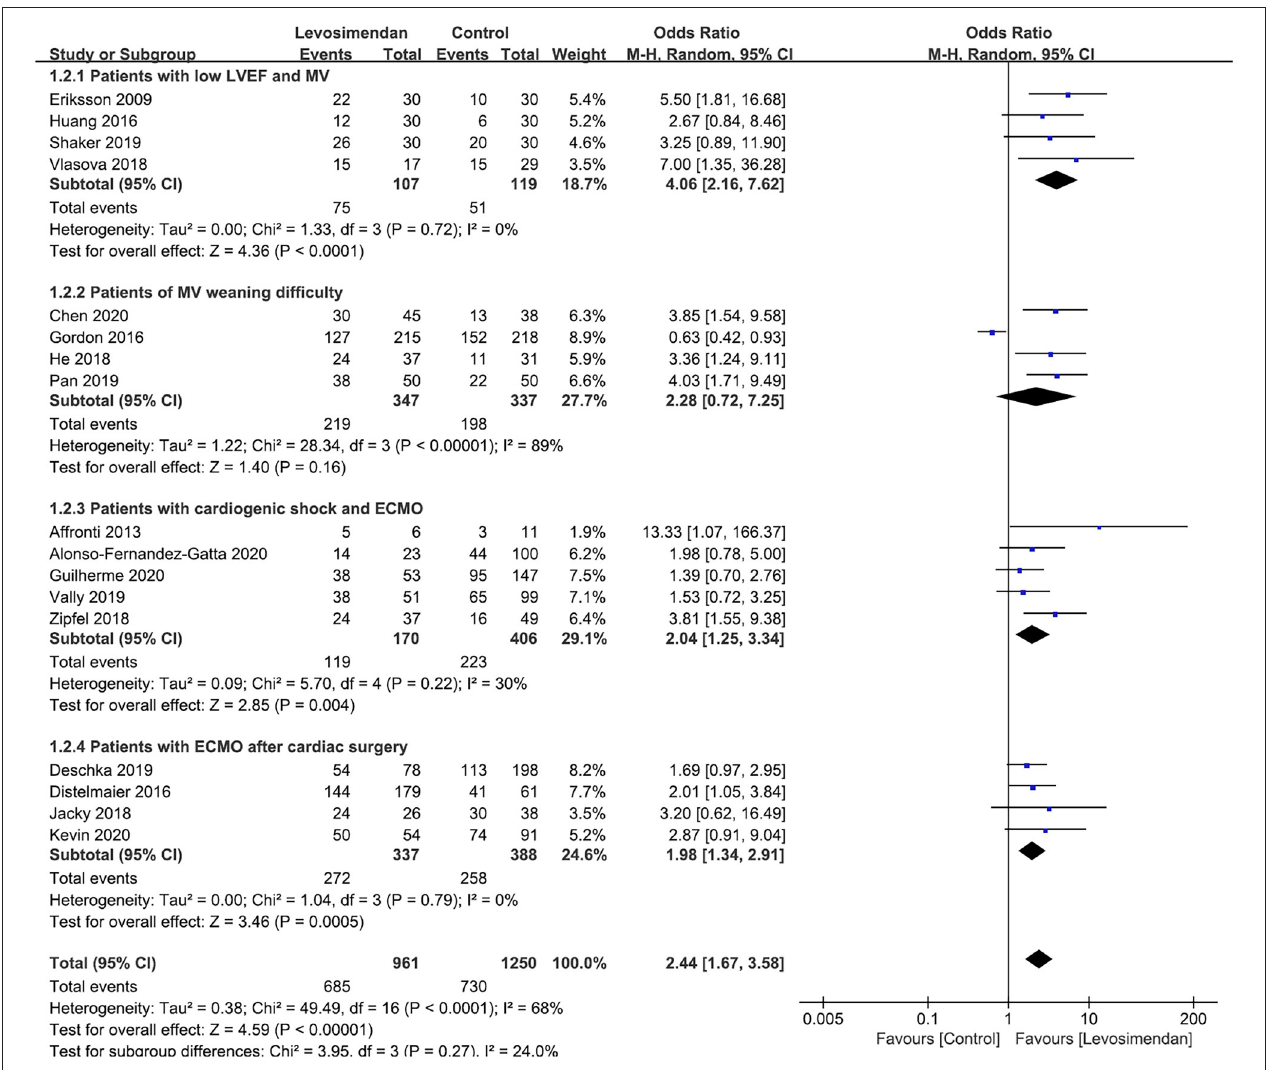
FIGURE 2 | Forest plots of the levosimendan therapy on weaning rates from cardiopulmonary support.